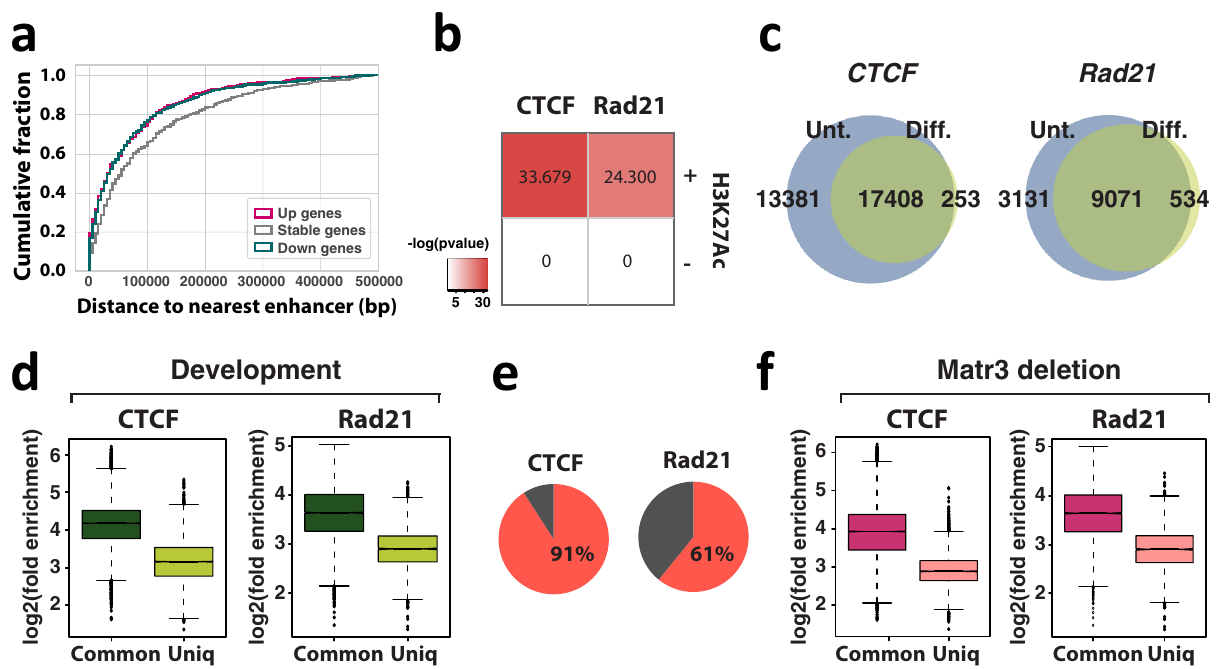
Fig. 6 Low occupancy sites of CTCF and cohesin are susceptible to developmental regulation and Matr3 loss. a Cumulative probability distribution of the distance to the nearest enhancer for up- and down-regulated genes versus stable genes in Matr3 KO compared to parental cells. Genes whose expression was altered upon Matr3 deletion resided at shorter genomic distances under a two-sided Kolmogorov-Smirnov (KS) test (up vs. stable: p = 3.62e-06, down vs. stable: p = 1.93e-09, up vs. down: p = 0.495, respectively). b Differently occupied regions of CTCF and Rad21 in Matr3 KO compared to parental cells nearby H3K27Ac marked chromatin associate with genes whose expression was altered upon Matr3 loss during differentiation. Signi fi cance of